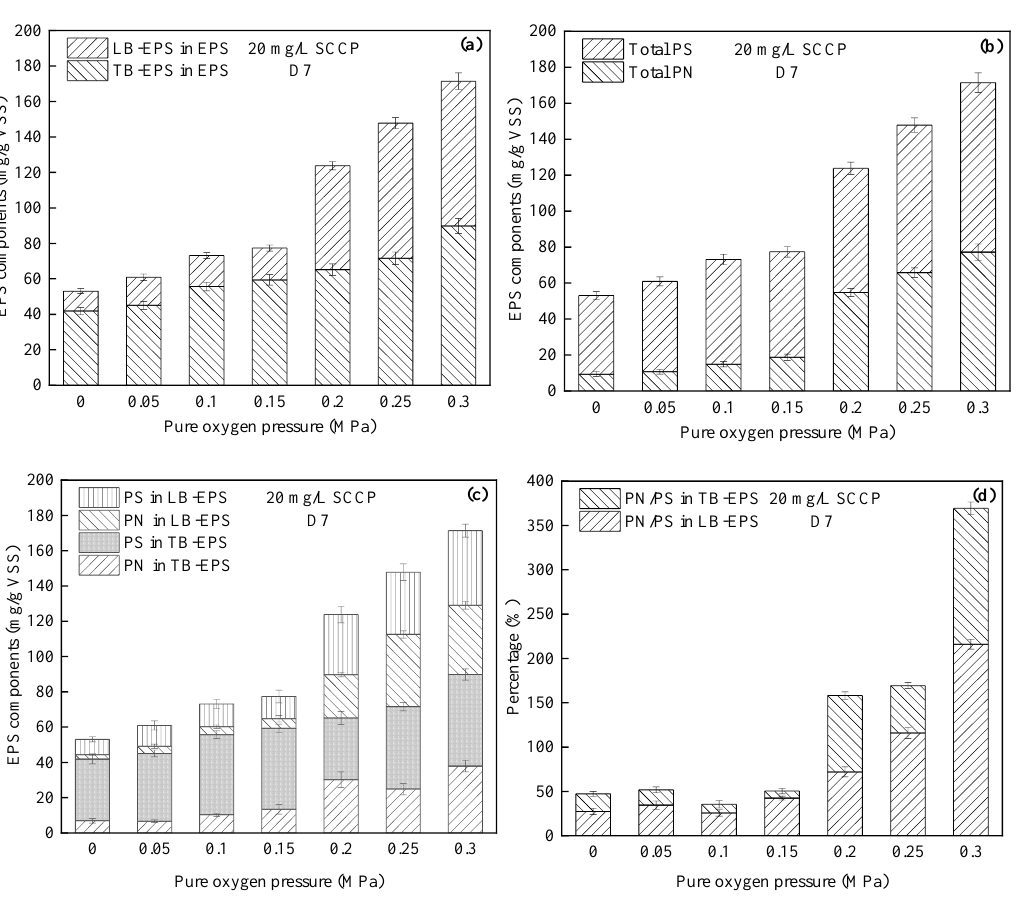
Figure 2. Relationship between different high-purity oxygen pressures and ( a ) LB-EPS and TB-EPS components; ( b ) PS, PN components; ( c ) EPS components; and ( d ) PN/PS ratio of EPS in a pressurized reactor. EPS, extracellular polymeric substances; LB-EPS, loosely bound EPS; PN, protein; PS, polysaccharide; TB-EPS, tightly bound EPS.